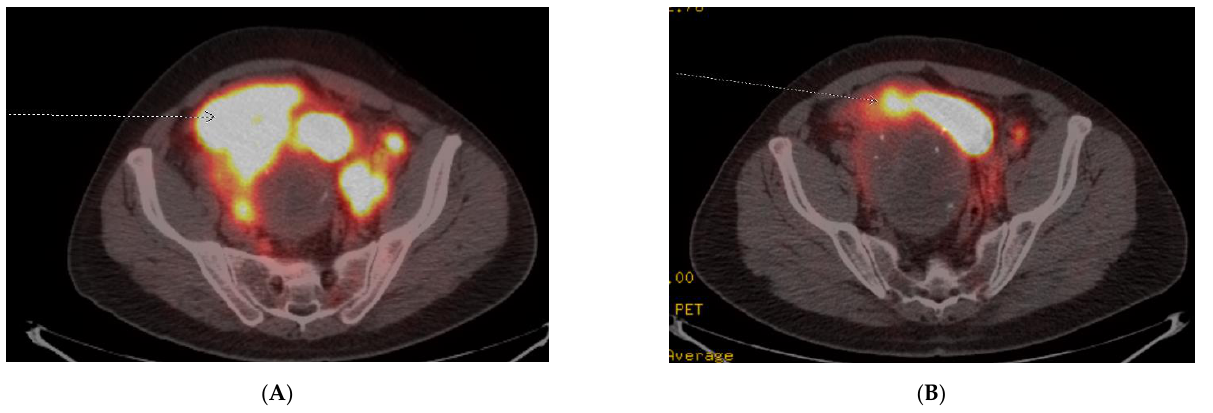
Figure 2. Case 3, ( A ) Baseline Gallium-68 Dotatate PET-CT demonstrated a large pelvic mass with retroperitoneal adenopa- thy and ipsilateral ureteric compression; ( B ) Follow-up Gallium-68 Dotatate PET-CT after 3 cycles of Lu-177 Dotatate demonstrated significant reduction in pelvic mass and retroperitoneal